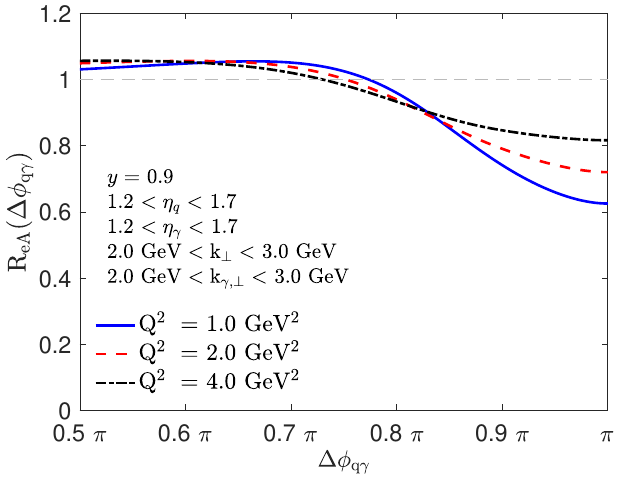
Figure 4 . R eA dependence of photon+quark correlations as a function of Q 2 .